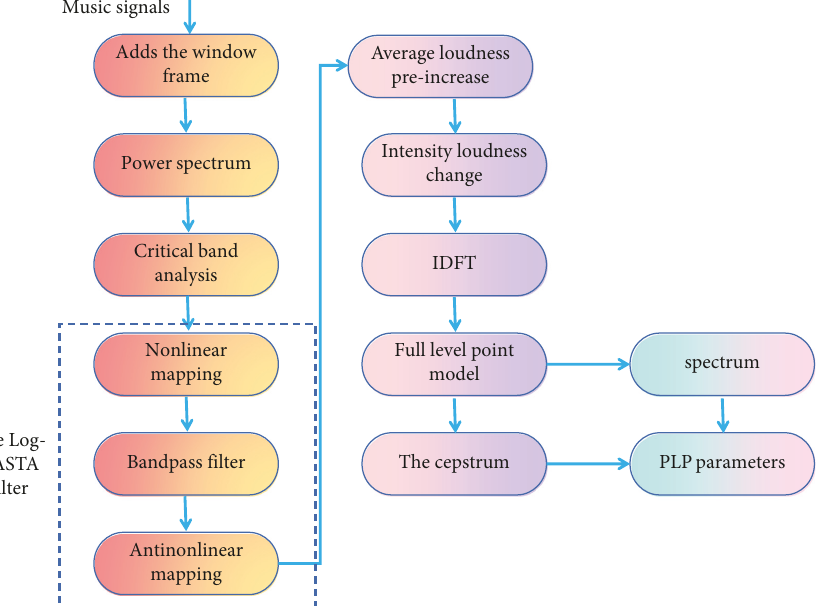
Figure 3: RASTA-PLP feature extraction